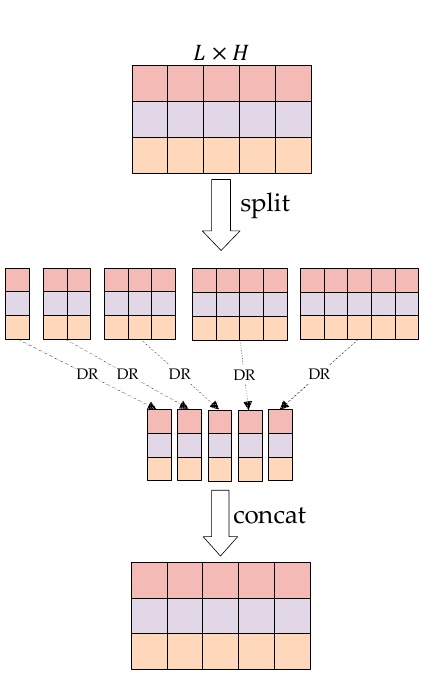
Figure 5. The process of head routing.